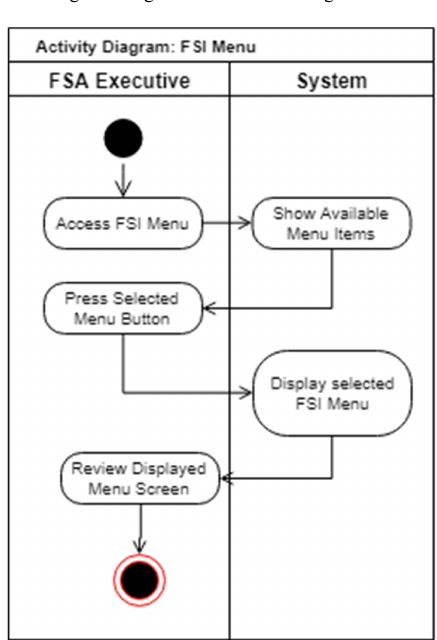
Fig. 2. Fragment of Use Case Diagram